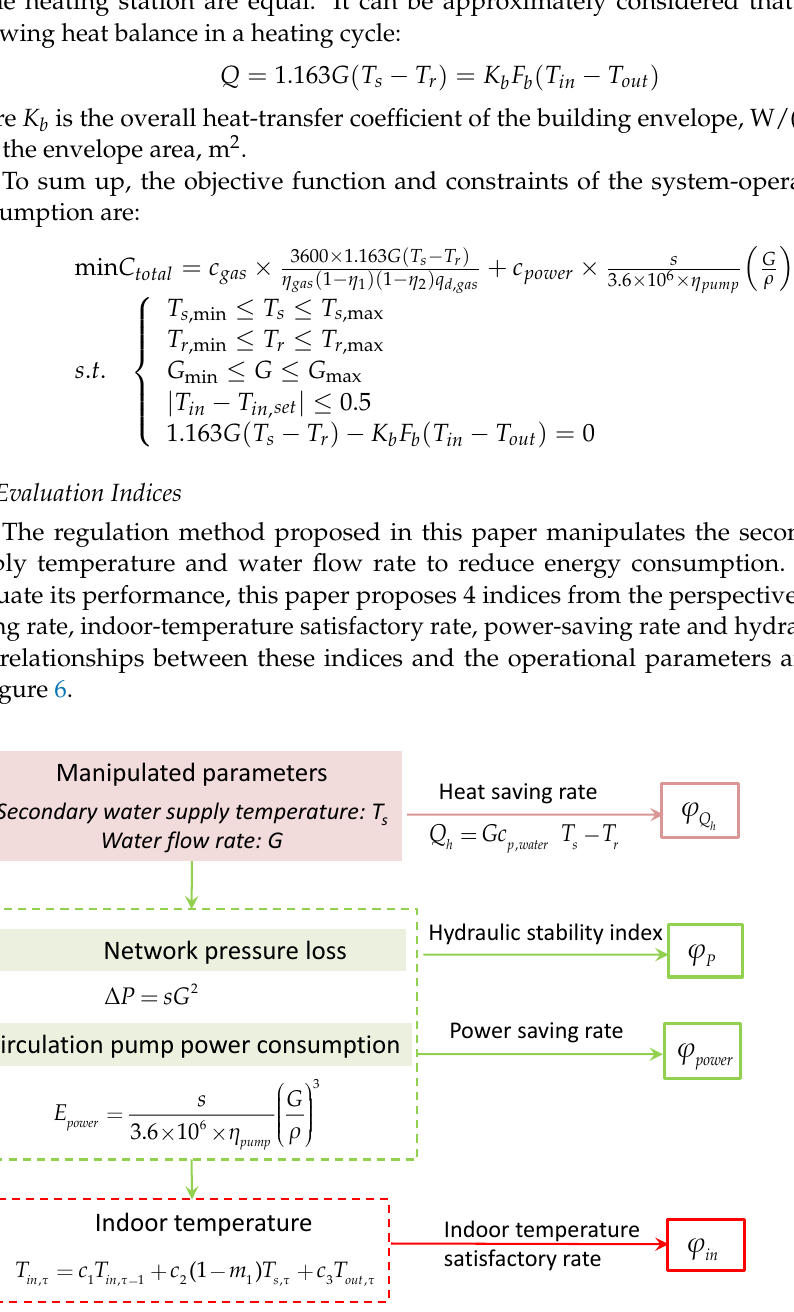
Figure 6. Flowchart of the evaluation indices.